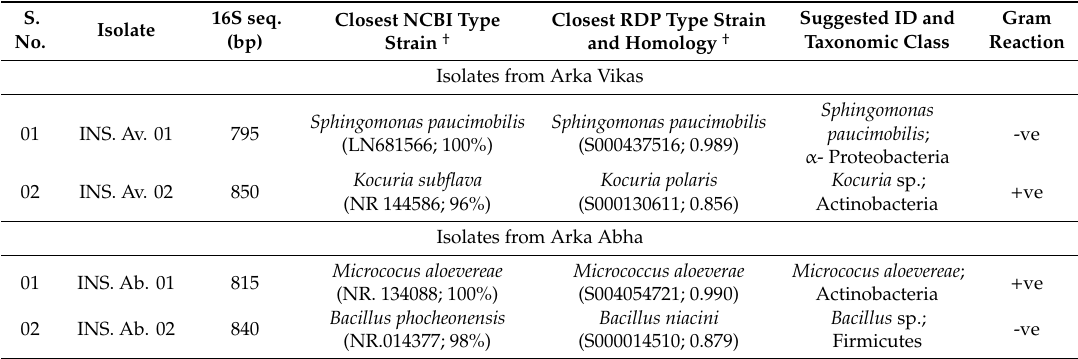
Table2. Identificationofbacterialstrainsisolatedfrom35-day-oldin vitrogrownbacteriaindex-negative seedlings of tomato “Arka Vikas” and “Arka